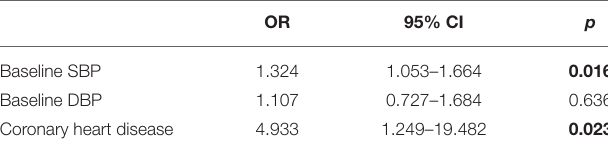
TABLE 2 | Binary logistic analysis of risk factors of END at 24h after